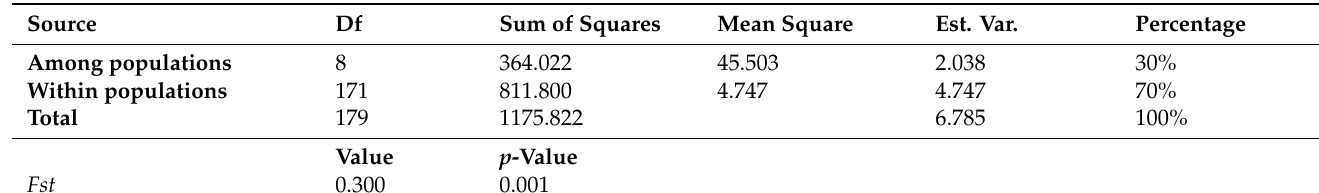
Table 5. AMOVA for comparisons within and between R. chalepensis populations collected from northern